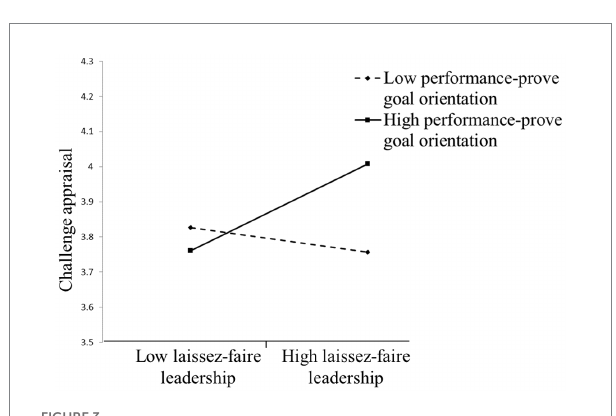
FIGURE 3 Performance-prove goal orientation moderates the relationship between laissez-faire leadership and challenge appraisal.